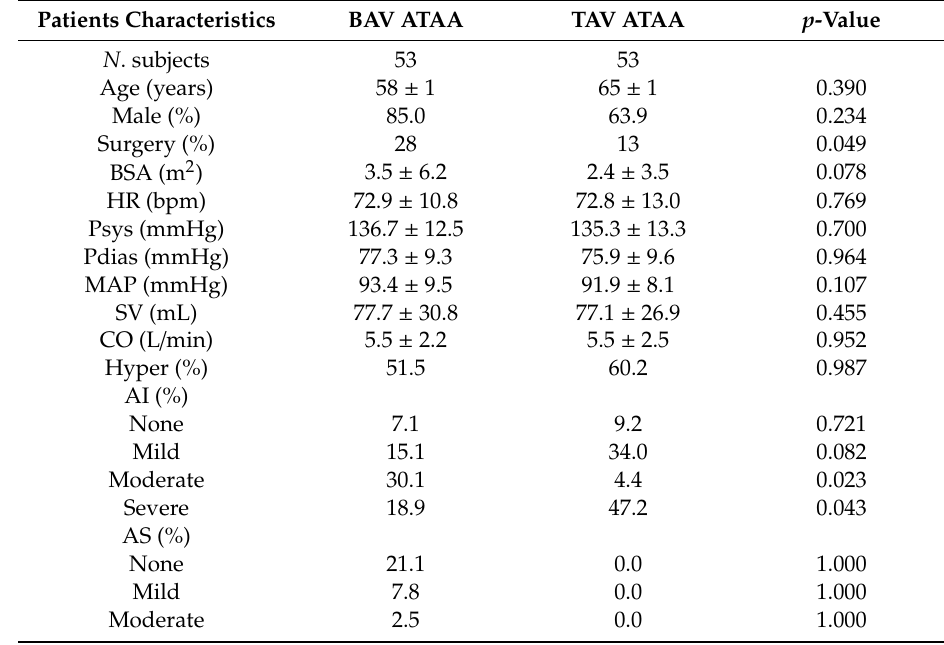
Table 1. Clinical and demographic characteristics of study population. Mann-Whitney test with α = 0.05. Patients